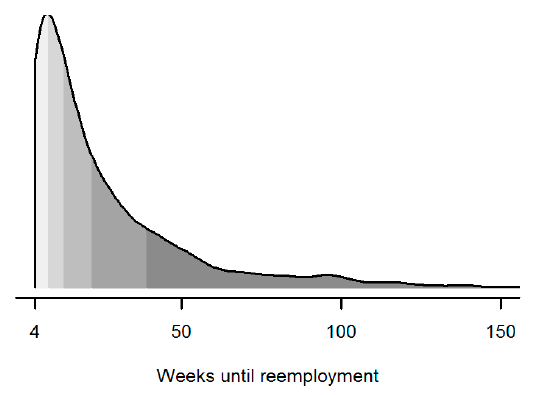
Figure 1. Distribution of weeks until reemployment. Each shade represents 20 percent of the sample.